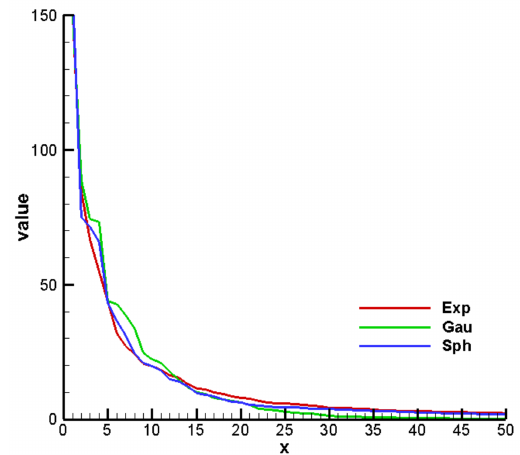
Figure 6. Ranked eigenvalues for three postulated variograms.